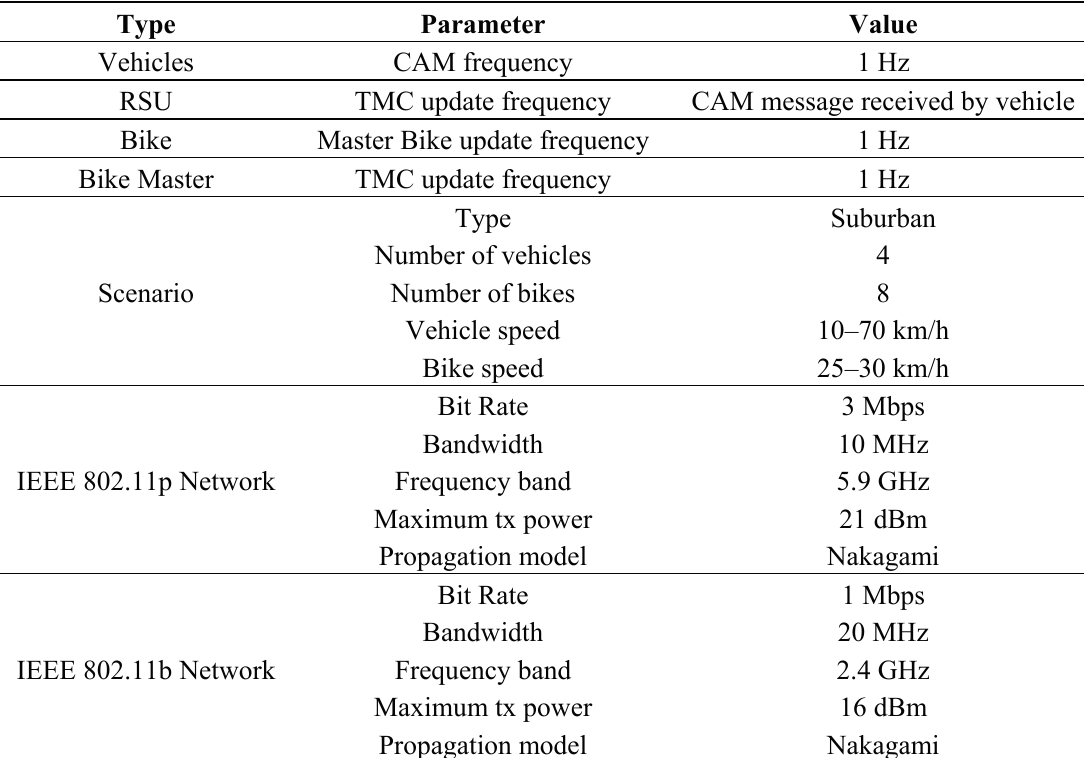
Table 1. Simulation